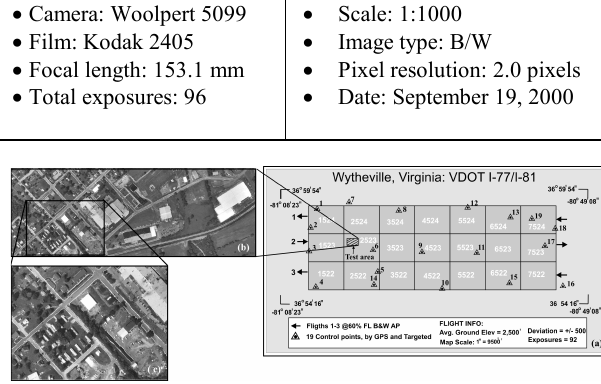
Figure 6: Geodetic control test field in Wytheville, VA (Courtesy of Zhou et al. (2004))